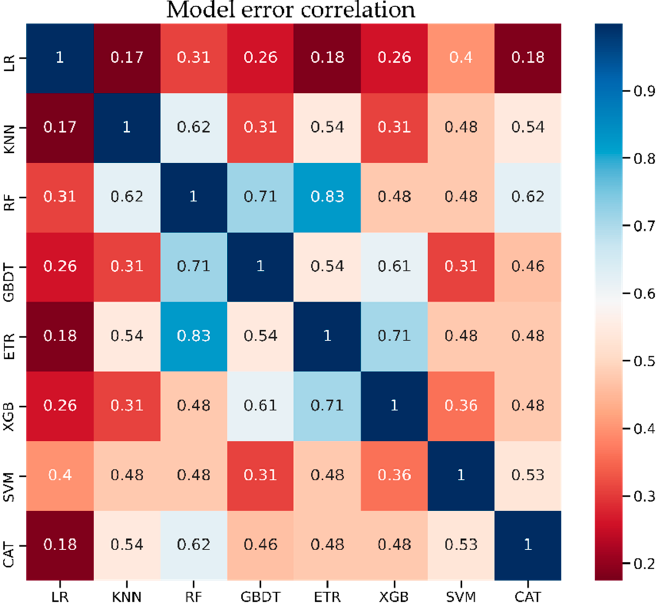
Table 10. Prediction results of different stacking models.